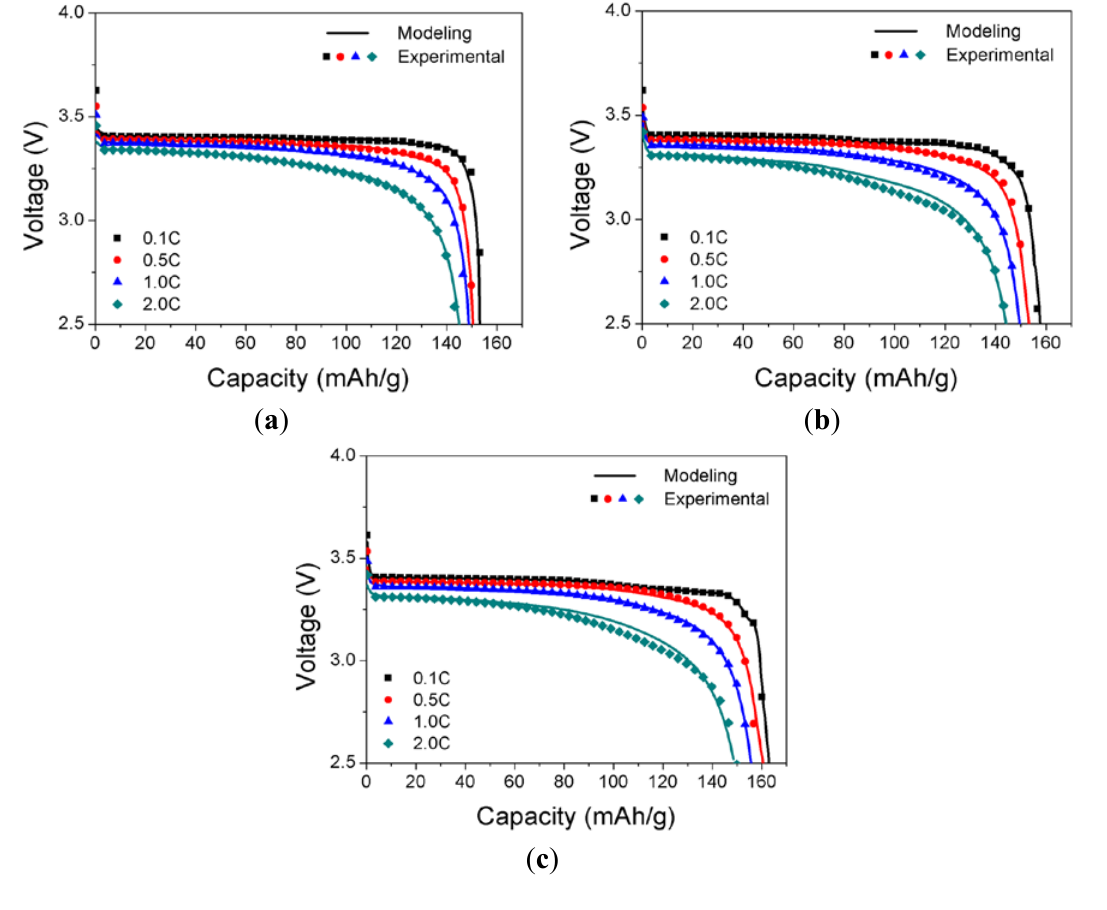
Figure 4. Comparison between the experimental and modeling discharge curves with discharge rates ranging from 0.5C to 5C: ( a ) case A; ( b ) case B; and ( c ) case